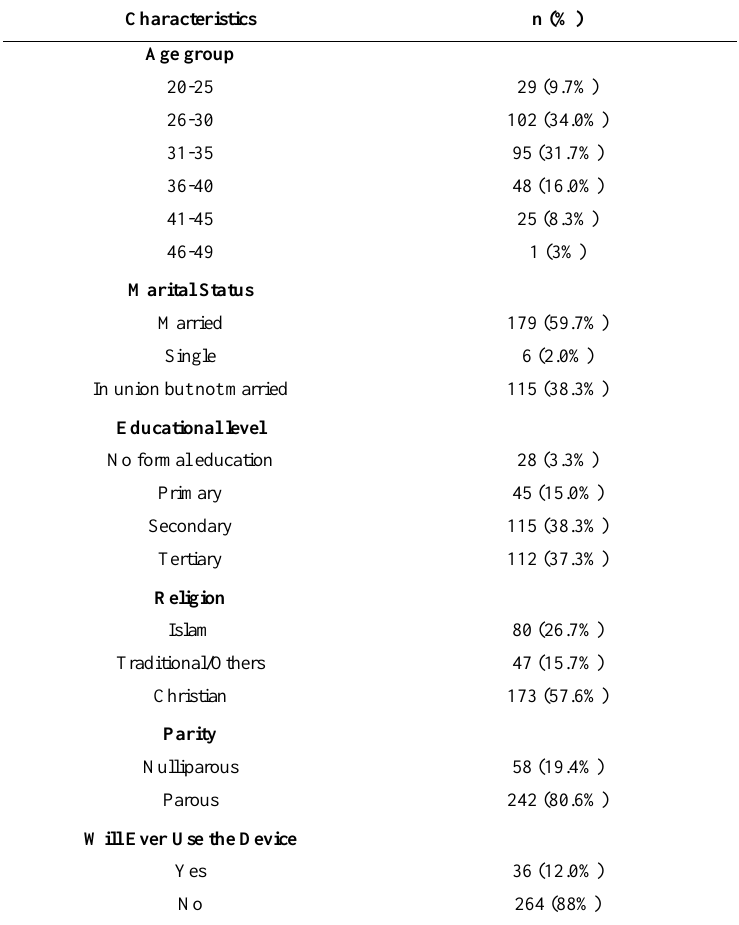
Table 1. Demographic characteristics of